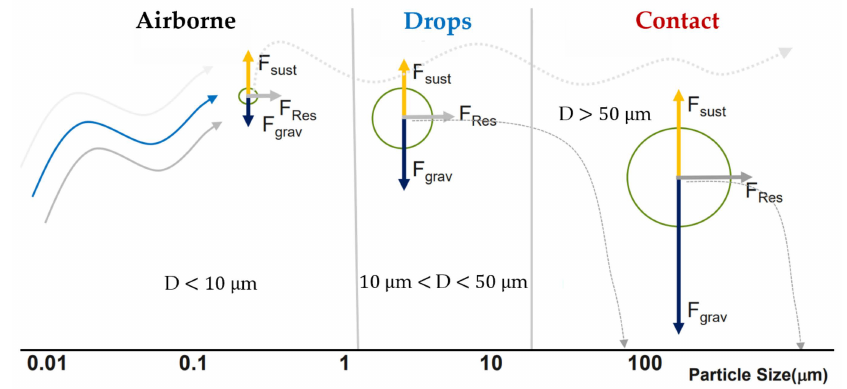
Figure 1. Typical trajectory of particles in air depending on their size, adapted from